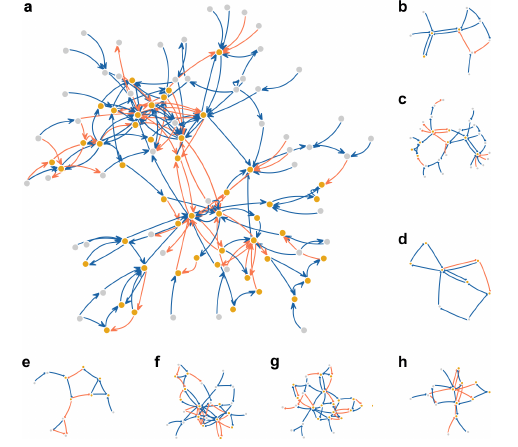
Fig. 2 . Causal-loop diagram (CLD’s for case studies). (a) Combination of all case studies together reveals that all case studies share variables forming a giant component. The case studies are: (b) forest resurgence in postwar El Salvador; (c) deforestation in Chaco, Paraguay; (d) certified coffee in Santander, Colombia; (e) land abandonment in Brazilian Amazon; (f) ecosystem services in Pampa, Argentina; (g) expansion of small-scale agriculture in Tapajos River, Brazil; and (h) soybean expansion in Uruguay. Nodes in yellow belong to feedback mechanisms whereas nodes in gray are drivers (variable outside feedbacks when pointing toward feedbacks). Blue links represent positive relationships whereas orange are negative links. Larger versions with labeled variables are available in the supplementary